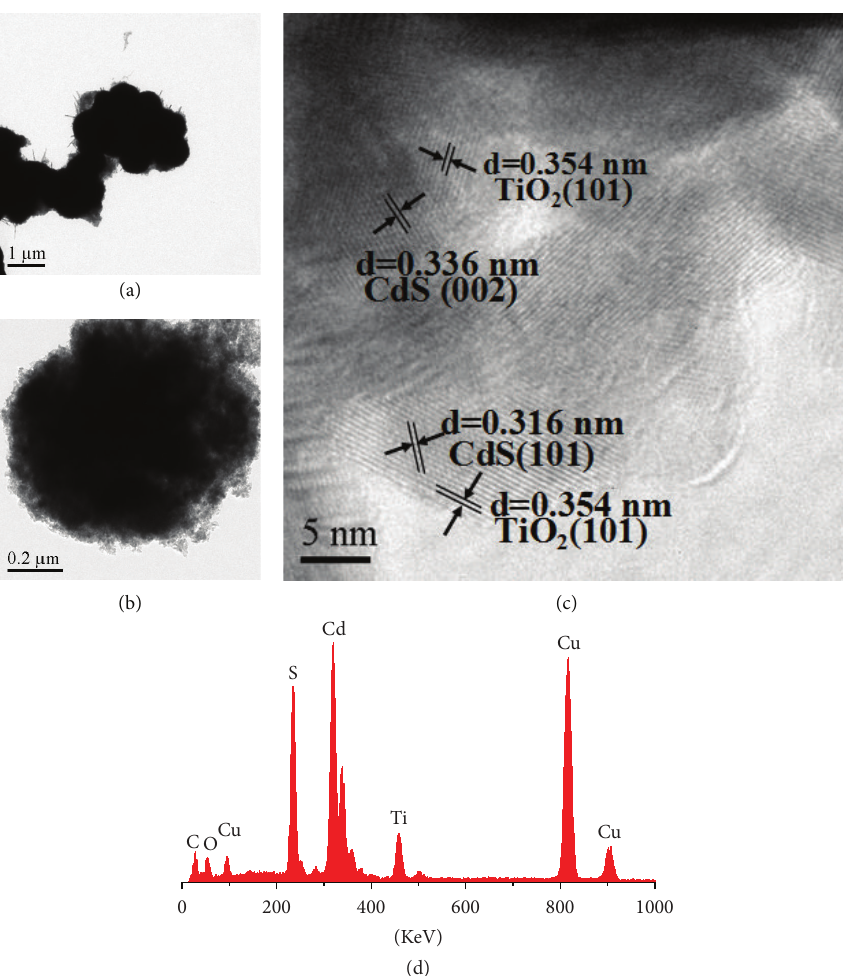
Figure 4: (a) and (b) TEM images of S1-10: 10wt% TiO 2 /CdS (10h), (c) HRTEM images of S1-10, and (d) EDS image of S1-10.